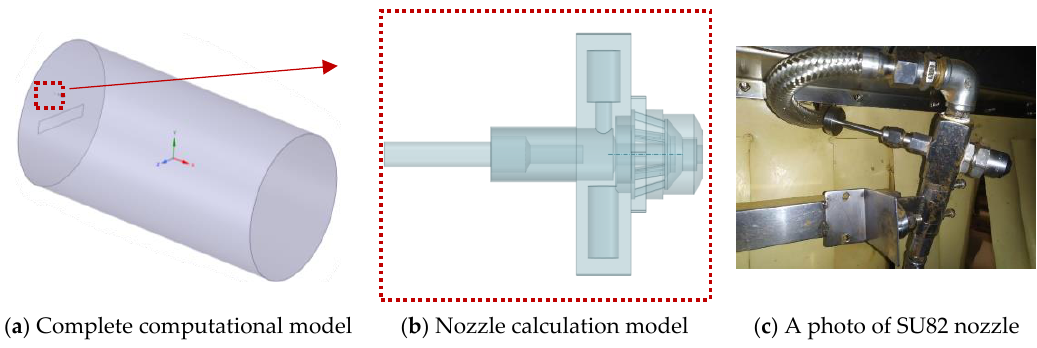
Figure 3. Calculation model of the flavoring equipment.